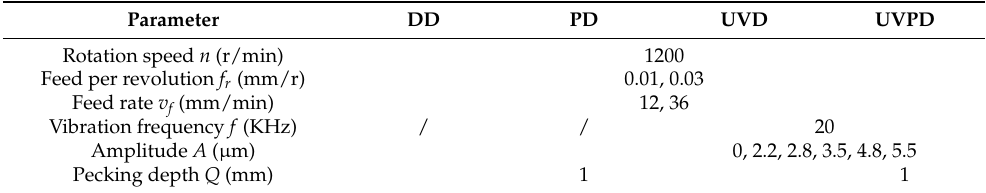
Table 2. Experimental